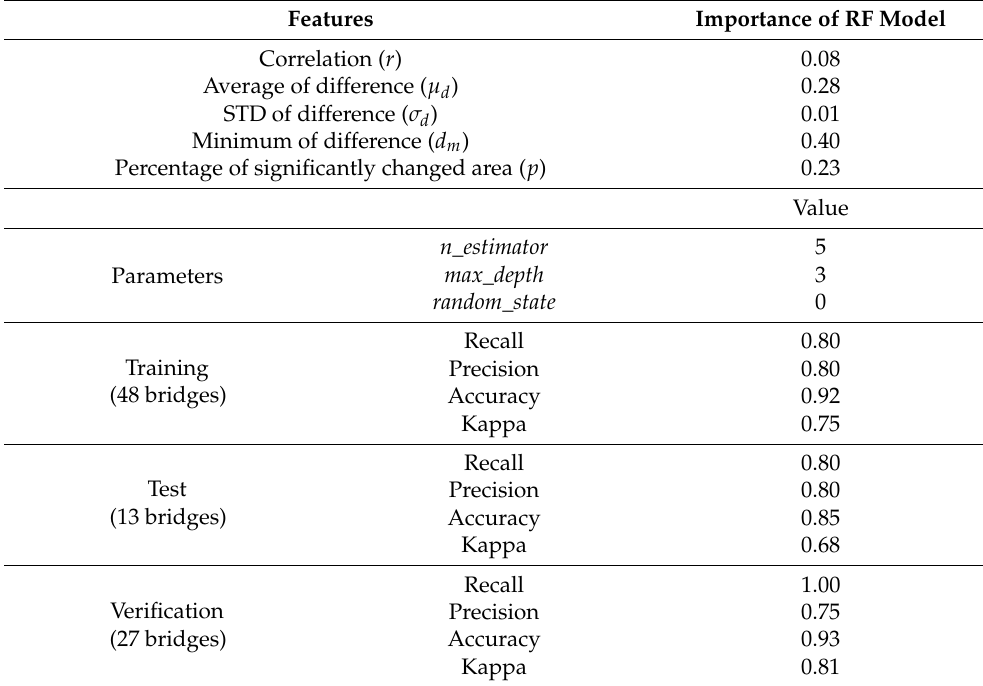
Table 10. The accuracies of the RF model using five features after applying the SMOTE